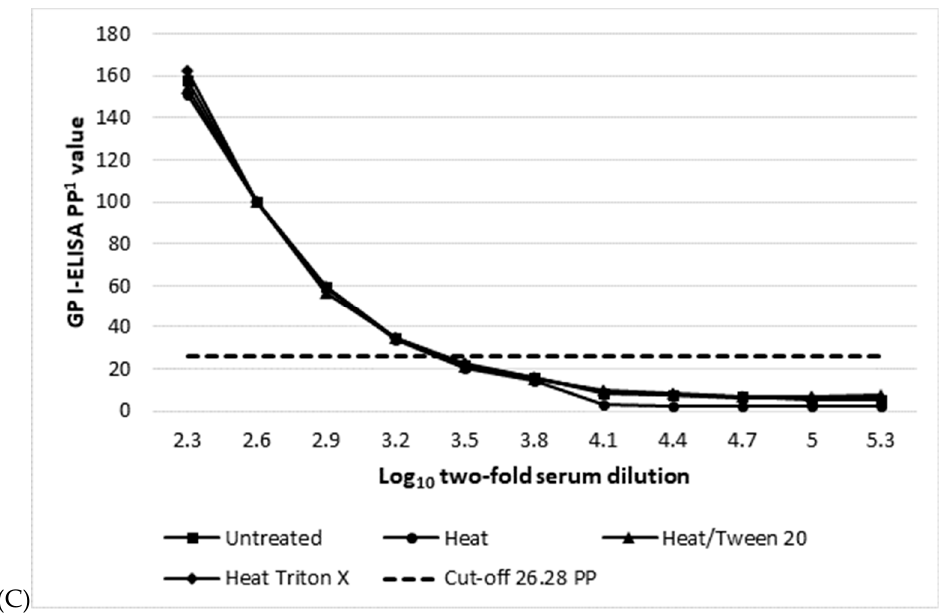
Figure 4. Dose-response kinetics of a positive EBOV IgG human serum before and after different inactivation procedures measured by a whole antigen (Wag), ( A ); nucleocapsid (NP), ( B ); and glycoprotein (GP), ( C ) indirect ELISA. 1 Percent positivity of internal positive control serum.